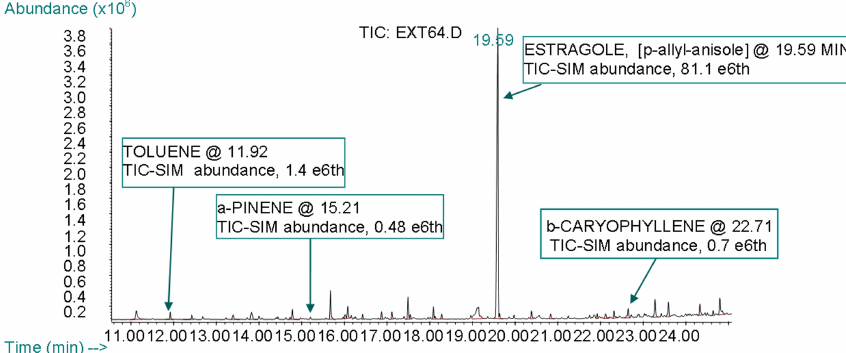
Fig. 2. Chromatogram of ambient air sampled within the oil palm canopy, showing a high abundance of estragole (p-allyl-anisole) but not of any of its derivatives. Oil palm plantation ambient air at ground level sampled on 25 May 2008. 15 m/z ions monitored.